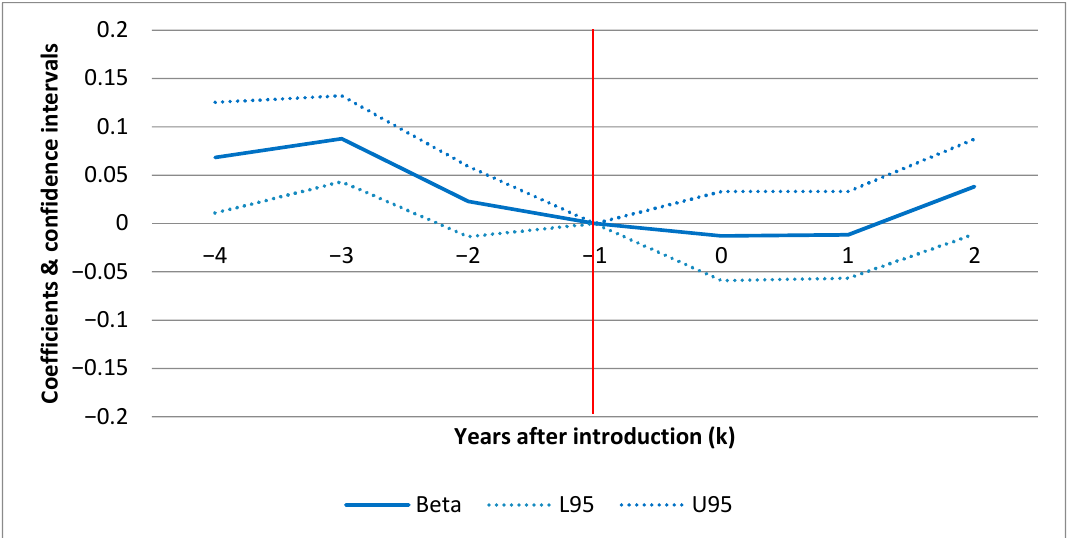
Figure 2. Yearly effects of POCT of HbA1c on ambulatory care sensitive diabetes condition (ACSCs) admissions, point estimates. Note: The dotted lines represent 95% confidence intervals. The model includes year and clinic fixed effects and the full set of covariates from Table 6.